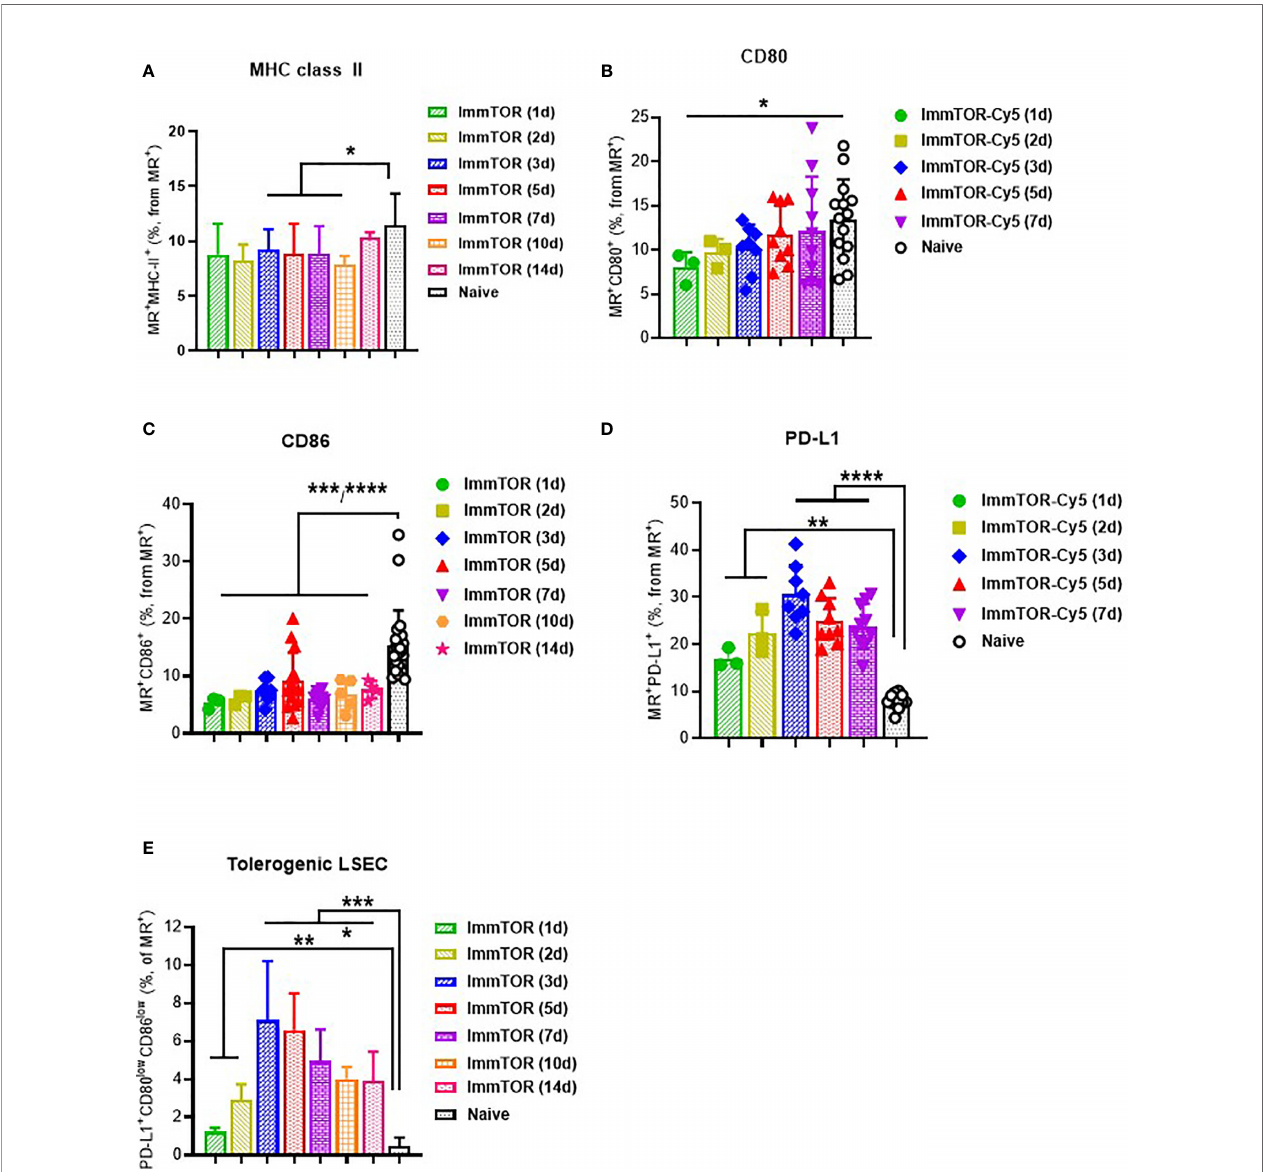
FIGURE 3 | ImmTOR induces a tolerogenic phenotype in LSECs. LSEC were isolated from liver at different time-points after i.v. injection of ImmTOR at 200 µg and analyzed by fl ow cytometry. Fractions of MHC-II+ (A) , CD80+ (B) , CD86+ (C) , and PD-L1+ (D) liver sinusoid endothelial cells (LSEC, identi fi ed as MR+F4/80 – CD68 – ) are shown. The fraction of tolerogenic LSEC (identi fi ed as PD-L1+CD80lowCD86low) is also shown (E) . Summaries of fi ve independent experiments are shown in which different and overlapping time-points were assessed (n=3-20 mice per group). Statistical difference in the size of respective fractions at different time-points vs. that in naïve mice is shown (* – p<0.05, ** – p<0.01, *** – p<0.001, **** – p<0.0001; Mann-Whitney